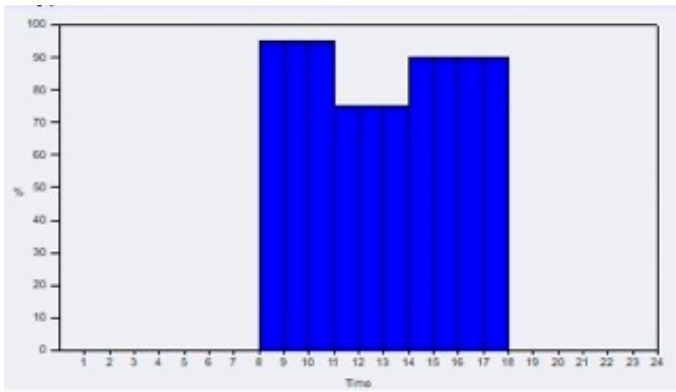
Figure A6. Monday Occupancy Pattern (input to BES).